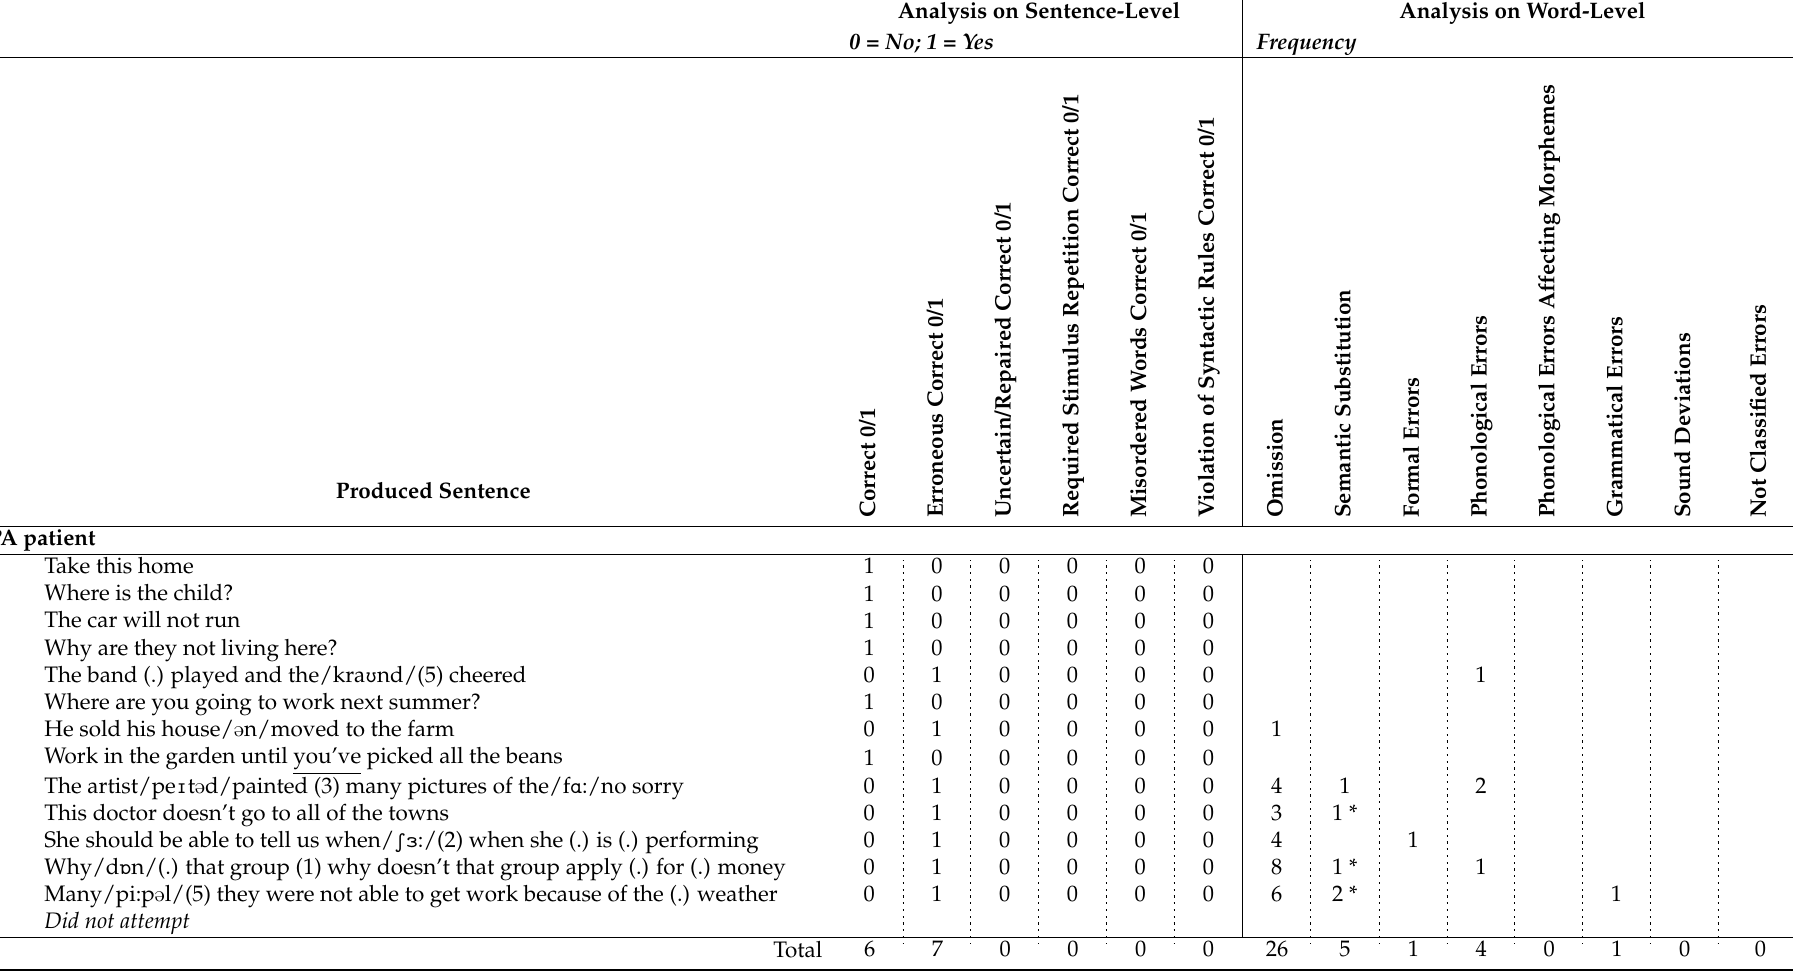
Table 2. PPA patients’ responses on the Multilingual Aphasia Examination Sentence Repetition